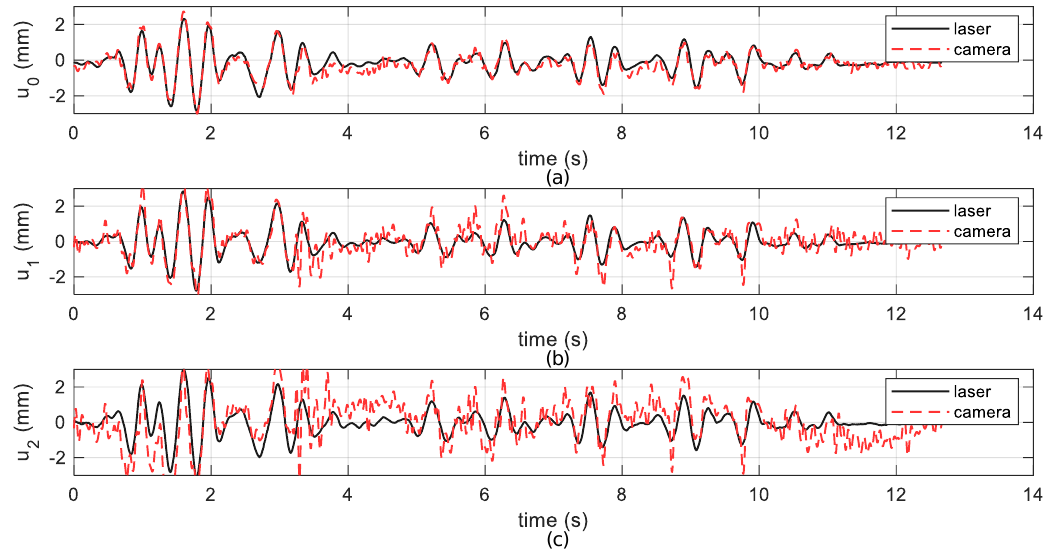
Figure 16. Measured results based on point-based projective rectification method: ( a ) the base story displacement u 0 , ( b ) the first story displacement u 1 , ( c ) the second story displacement u 2